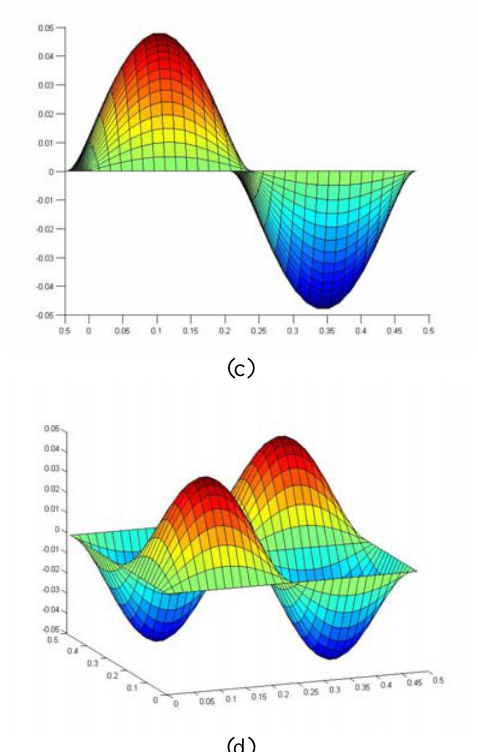
Fig. 5. Some of the basis shapes for the 9-DV problem (Note that Fig.(b) is the front view of q 2 whereas Fig.(c) is the side view of q 3